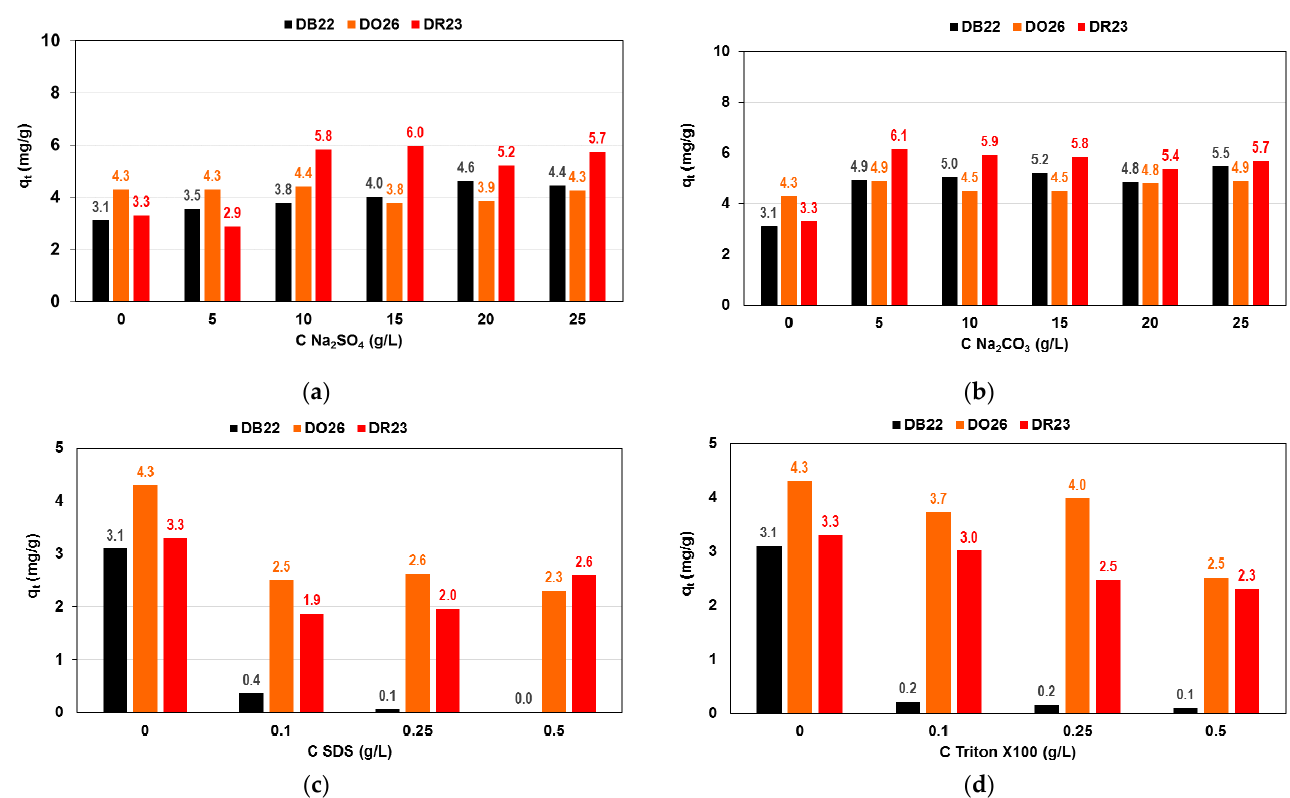
Figure 8. Impact of ( a ) sodium sulfate and ( b ) carbonate as well as ( c ) anionic and ( d ) non-ionic surfactants on DB22, DO26 and DR23 uptake by A21 resin.